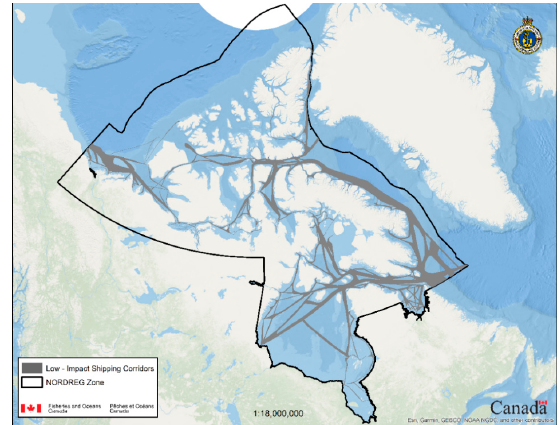
Figure 1. Northern Low Impact Shipping Corridors within the Northern Canada Vessel Traffic Services Zone (NORDREG Zone).